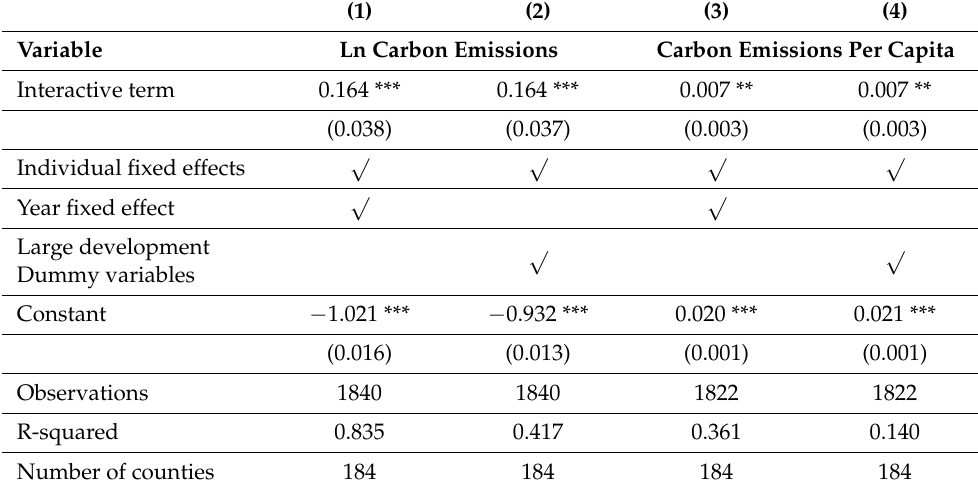
Table 3. WDS and Total Carbon Emissions and Per Capita Carbon Emissions.